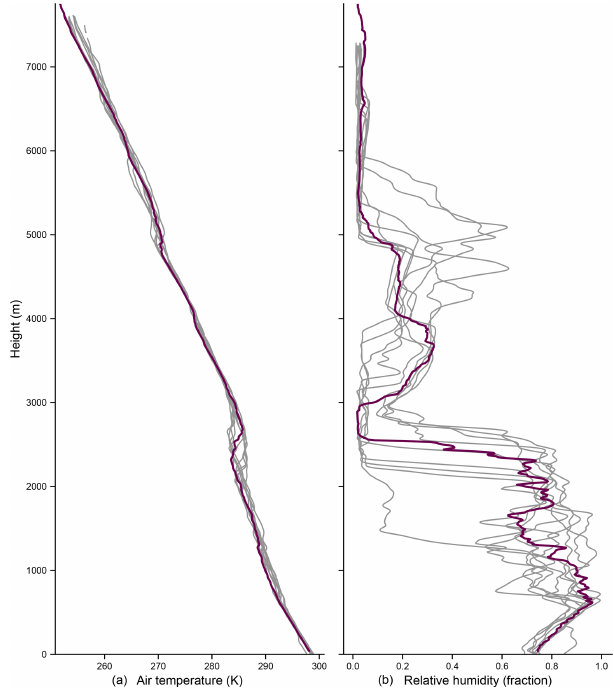
Figure 9. Ocean temperature profiles as measured by AXBTs de- ployed from the P-3 on 19 January 2020. Data are shown between the near-surface and a depth of 150m, though the actual profiles extend to nearly 1000m depth. The inset shows ocean tempera- tures in the first few meters along with measurements from the five SWIFT buoys (see Quinn et al., 2021) surrounded by the AXBT deployments. Three of the 40 AXBTs deployed did not provide valid